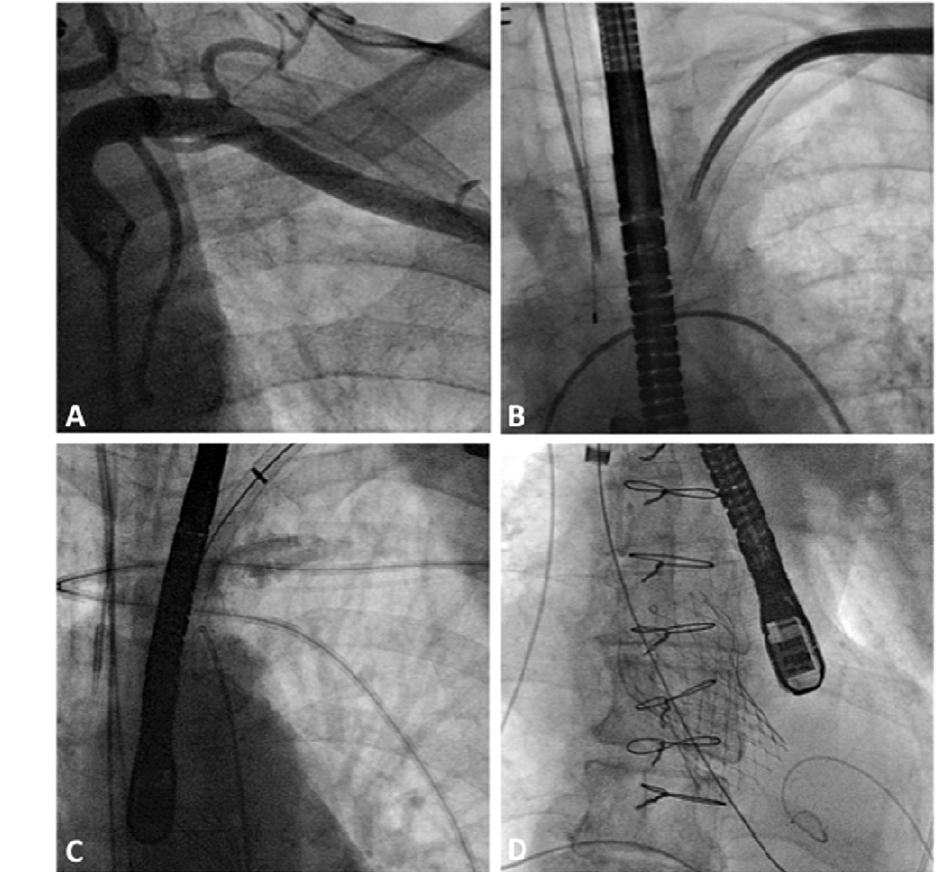
Figure 5. Fluoroscopic illustration of TAVI via. Left subclavian approach. A) Pre-operative angiogram of left subclavian artery using 5-Fr JR4 catheter inserted via right femoral artery. B) Insertion of 18-Fr introducer sheath under fluoroscopic guidance. C) Pigtail catheter inserted via right femoral artery to guide positioning of TAVI prosthesis. D) Full deployment of CoreValve R (cid:13) inserted via left subclavian arterial sheath on a stiff guidewire placed in the LV